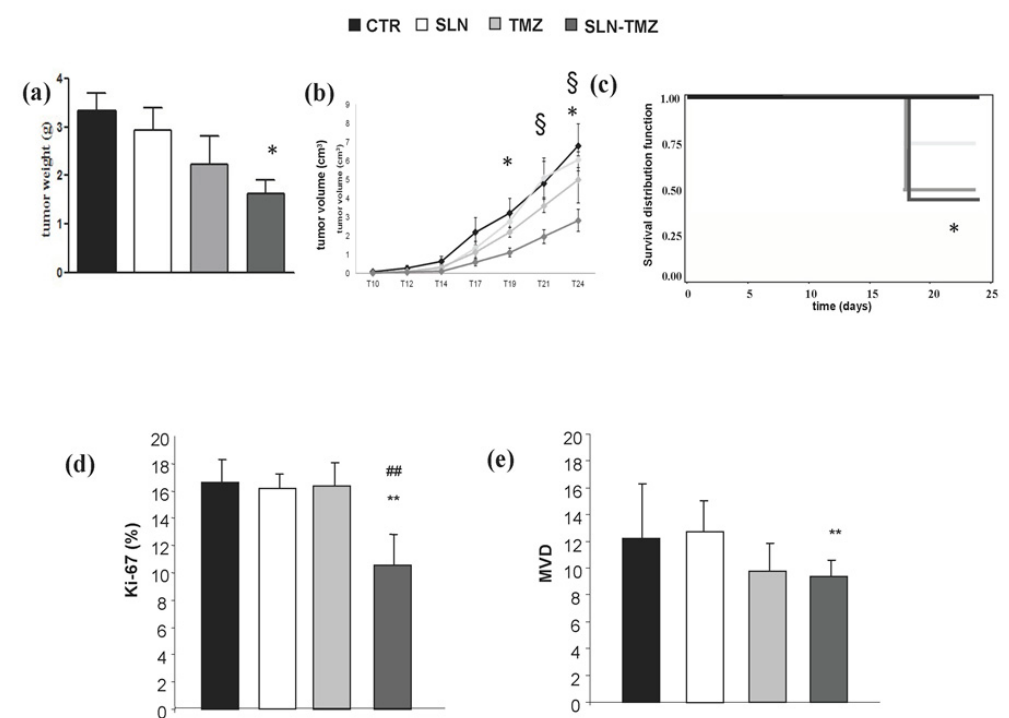
Figure 8. In vivo experiments on mouse melanoma model. C57BL6/J mice were injected subcutaneously with B16-F10 cells (1 × 10 5 in 100 µ L/mouse). Ten days after the tumor injection, mice were treated three times a week for two weeks by i.v. injection of free TMZ, SLN-TMZ or empty SLN (100 µ L each–0.5 µ M/g) or the same volume of PBS as control. Mice were sacrificed at the end of the experiment. Then, tumors, organs and blood were collected and kept for histological analysis. Graphs show: ( a ) tumor weight (grams—mean ± SEM), ( b ) tumor volume curves (cm 3 —mean ± SEM), ( c ) survival distribution function, ( d ) % of Ki-67-positive cells among tumor cells ( e ) MVD determined by counting the individual CD31+ microvessels. Ten randomly selected areas from three tumors from each group were analyzed; data are expressed as media and interquartile ranges. Statistical analyses were performed using one-way ANOVA and the Dunnett test. * p < 0.05; ** p < 0.01 compared to the PBS-treated group. § p < 0.05 compared to the empty SLN group. ## p < 0.001 compared to the TMZ-treated group.